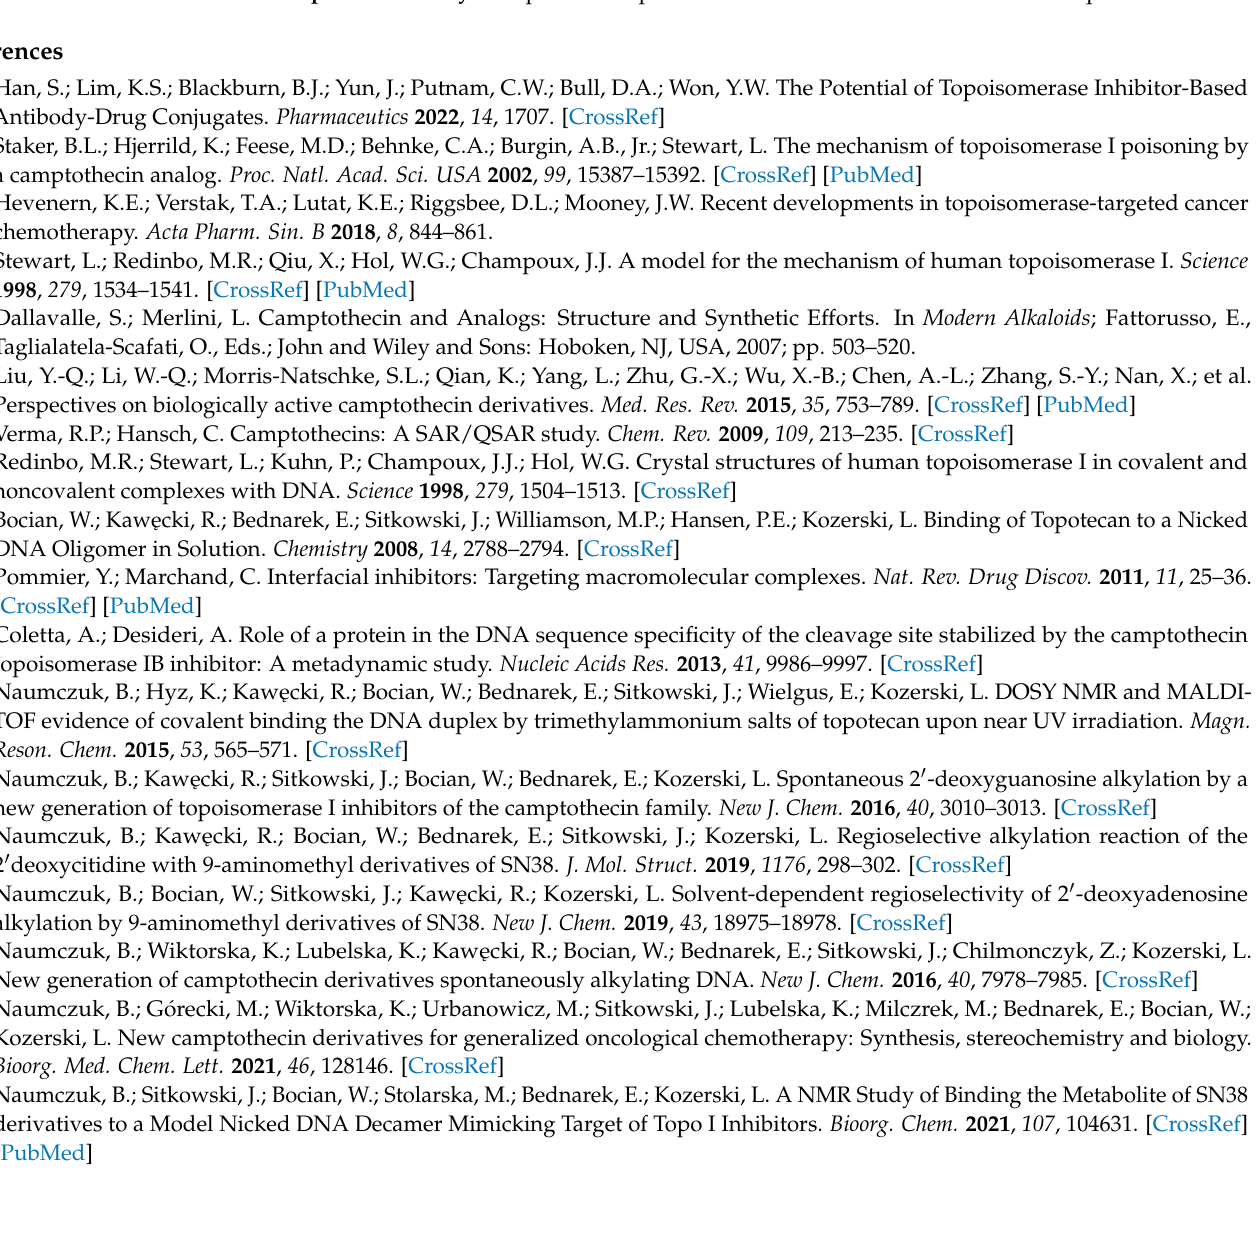
Table S3: The 1 H NMR chemical shift changes in SN38 derivative 1 after addition of it to DNA. Author Contributions: Conceptualization, W.B., L.K. and B.N.; methodology, W.B. and B.N.;